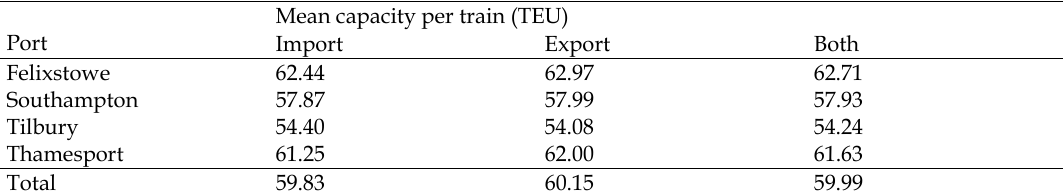
Table 3. Mean TEU capacity provided per train, by port and direction of flow